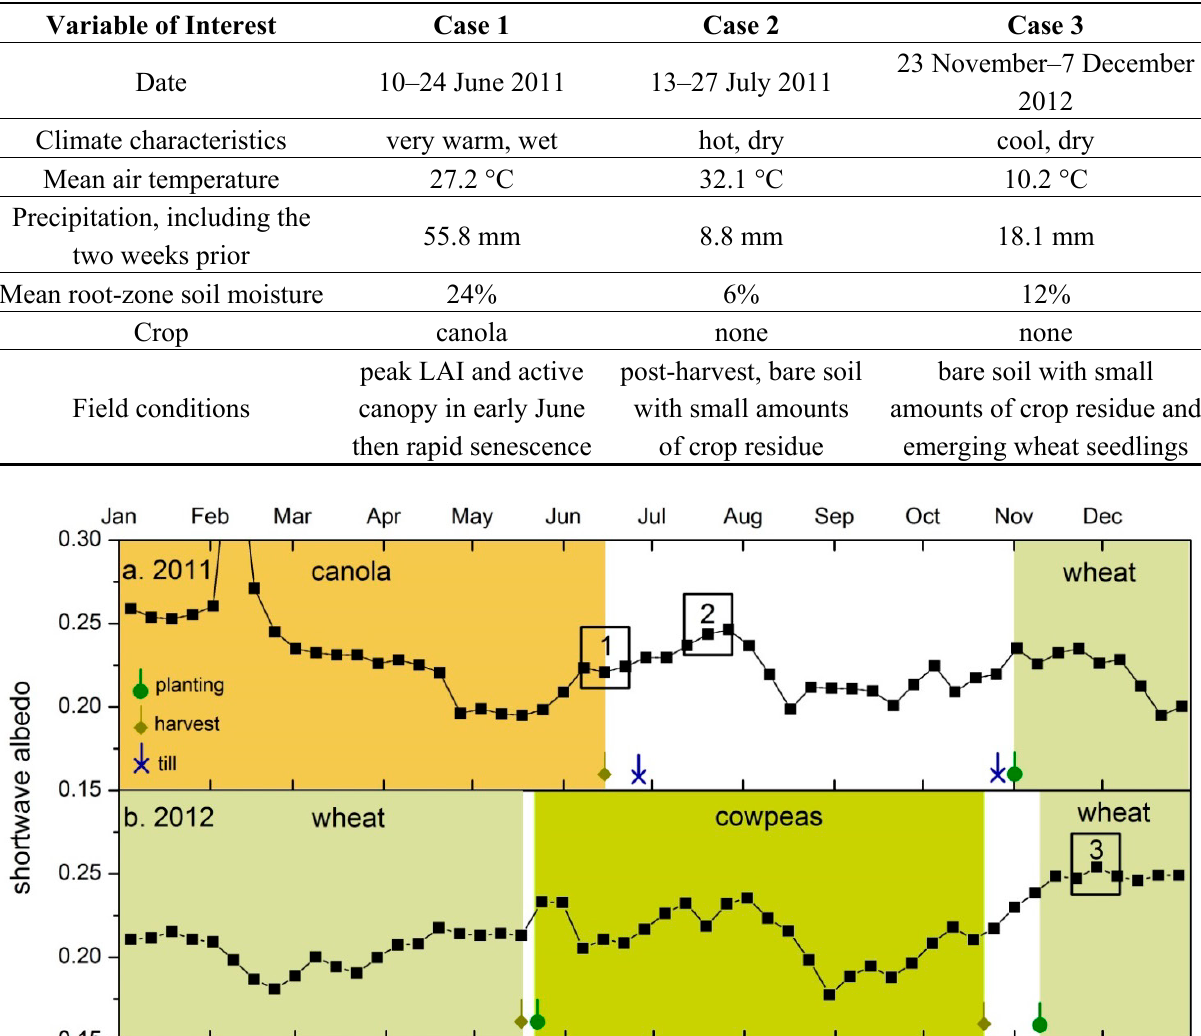
Table 1. Brief description of Cases 1–3 highlighting canopy and surface meteorology differences.